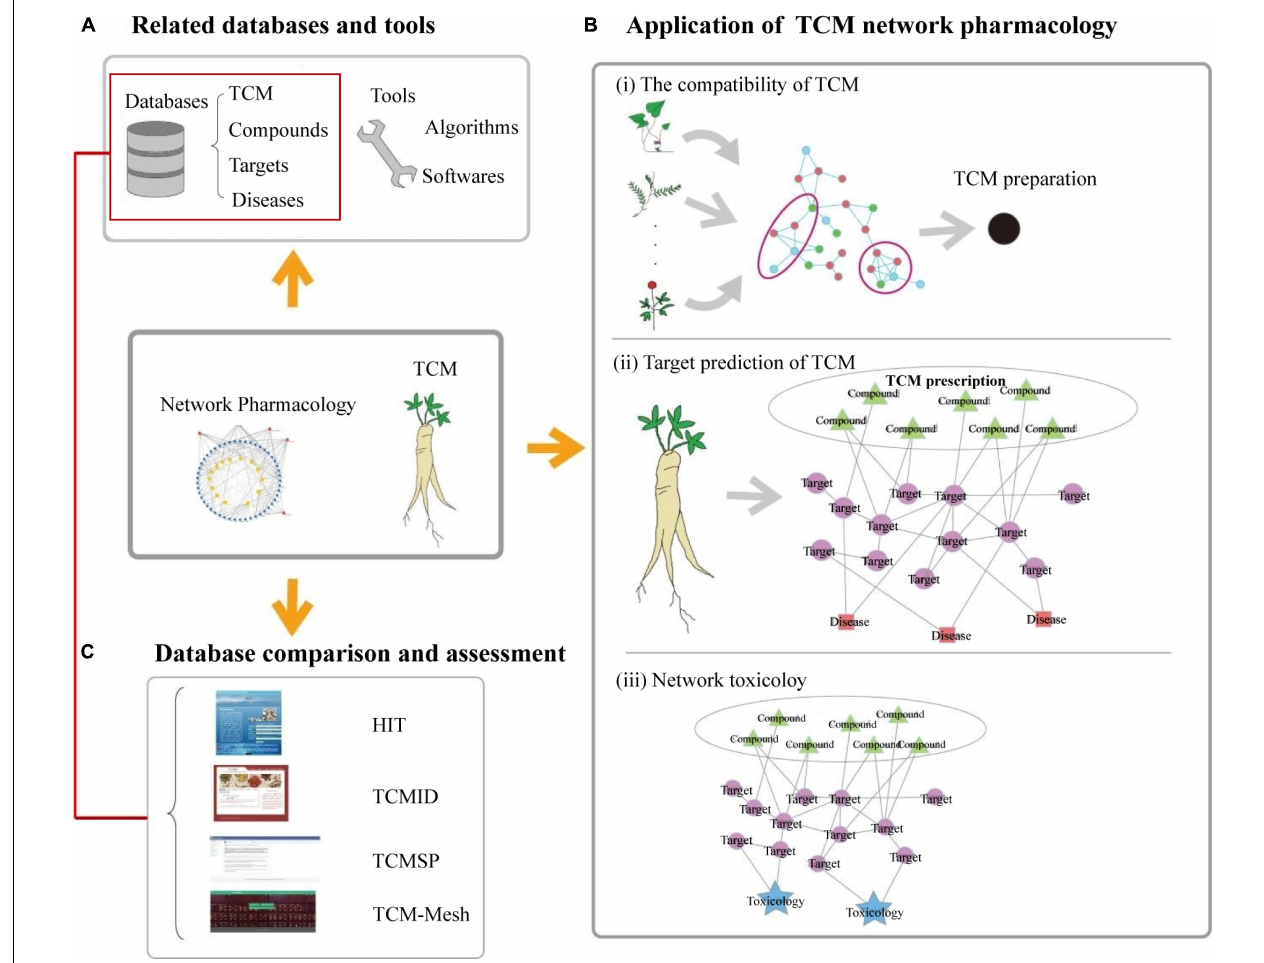
FIGURE 1 | Overall schema of the databases, tools, and applications of TCM network pharmacology analysis. (A) Related databases (TCM, compounds, targets, and disease databases) and tools (algorithms and software) used for TCM network pharmacology research. (B) The application of network pharmacology to TCM research: (i) the compatibility of TCM; (ii) target prediction of TCM; and (iii) network toxicology. (C) Comparison among several TCM databases based on the general statistics and search